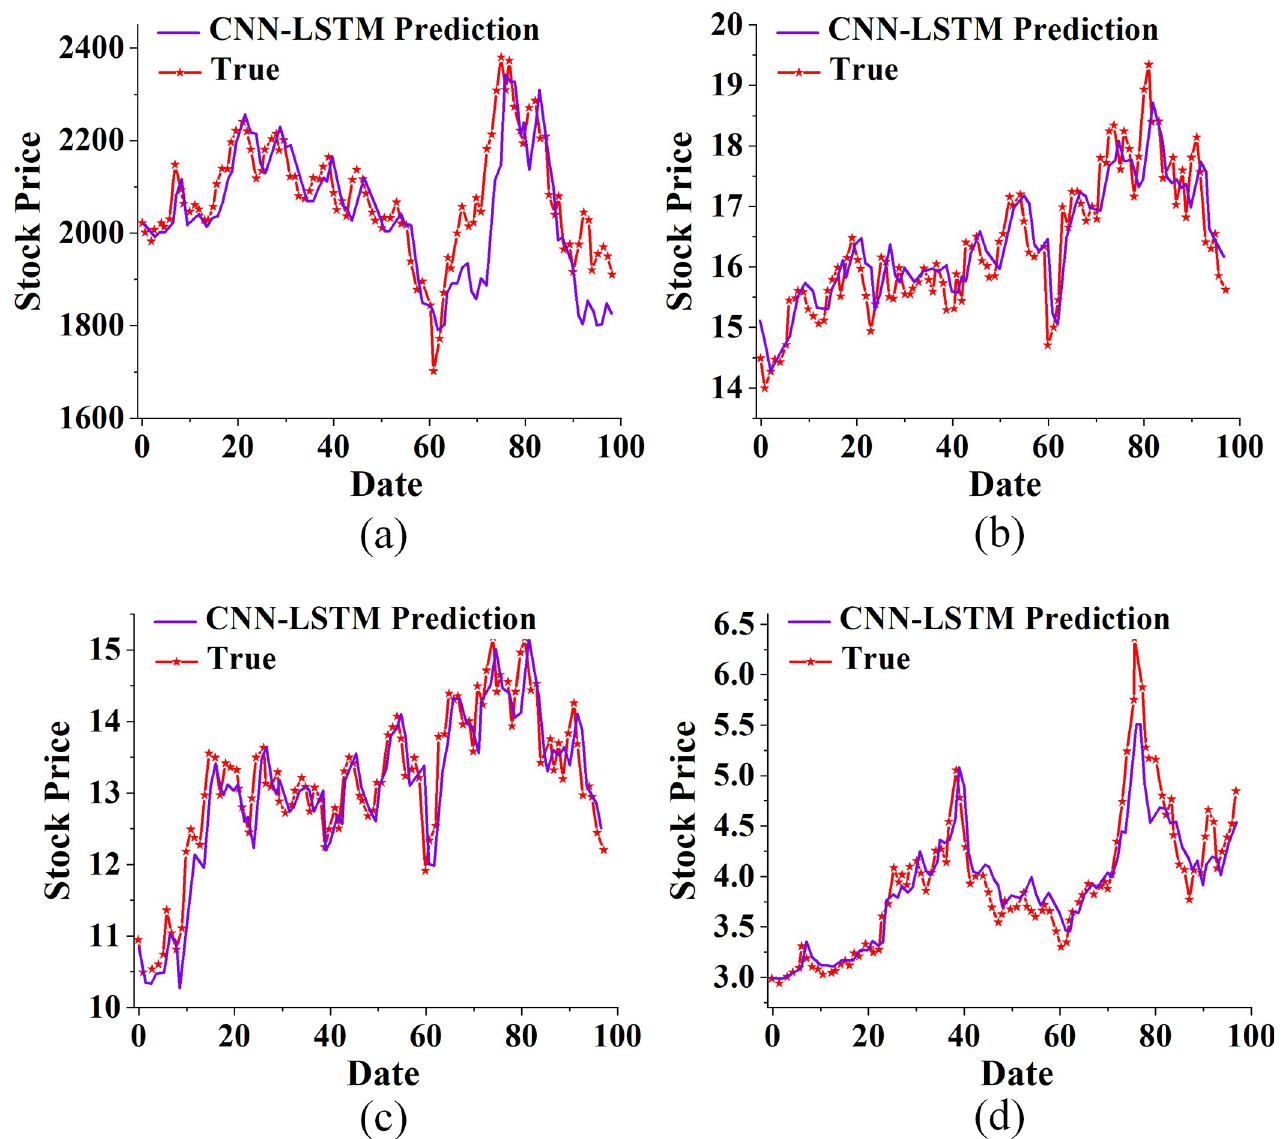
Fig 8. The proposed CNN-LSTM algorithm predicting the trend of real estate index and stock (a. China Real Estate Index (399,241); b. Poly Development (600048); c. Gemdale Group (600383); d. Nanshan Holdings (002314).